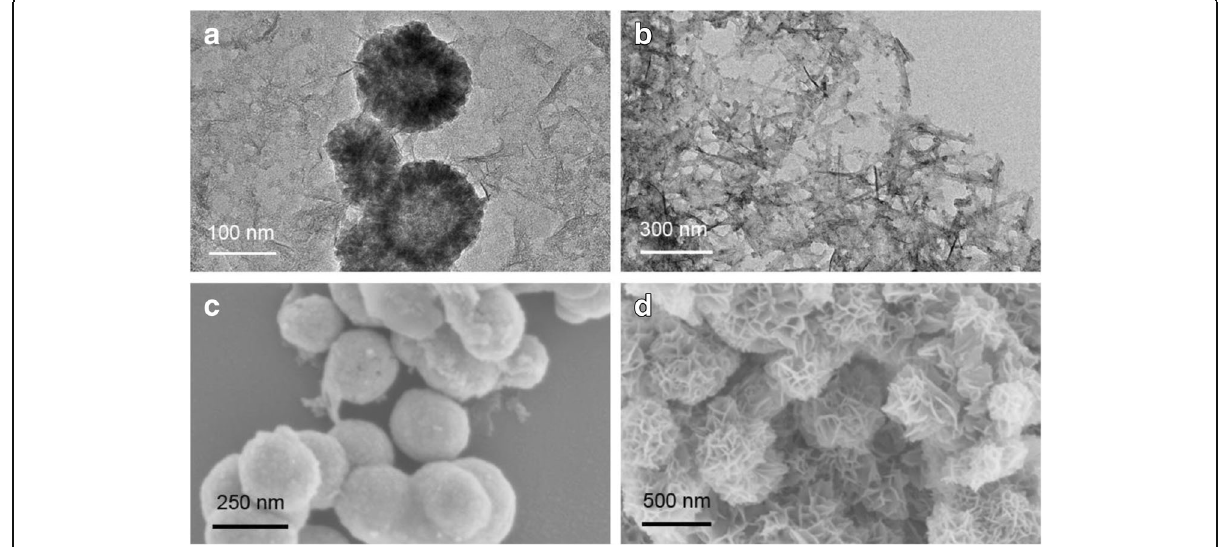
Fig. 1 a , b TEM and c SEM micrographs of the Fe-Pd@PGA NPs. d SEM micrograph of bare Fe-Pd